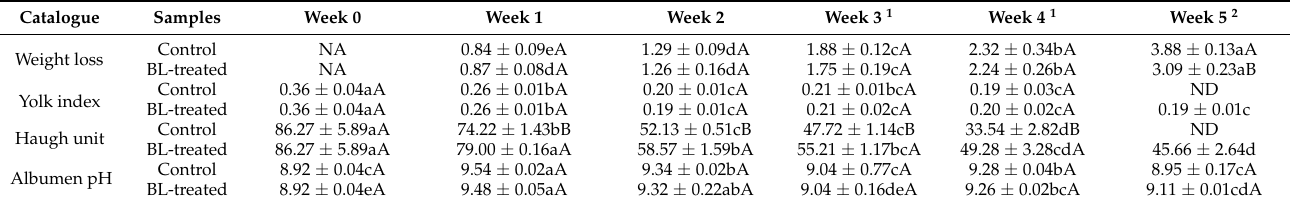
Table 1. Effect of blue light irradiation on weight loss (%), yolk index, Haugh unit and albumen pH of eggs during 5 weeks of